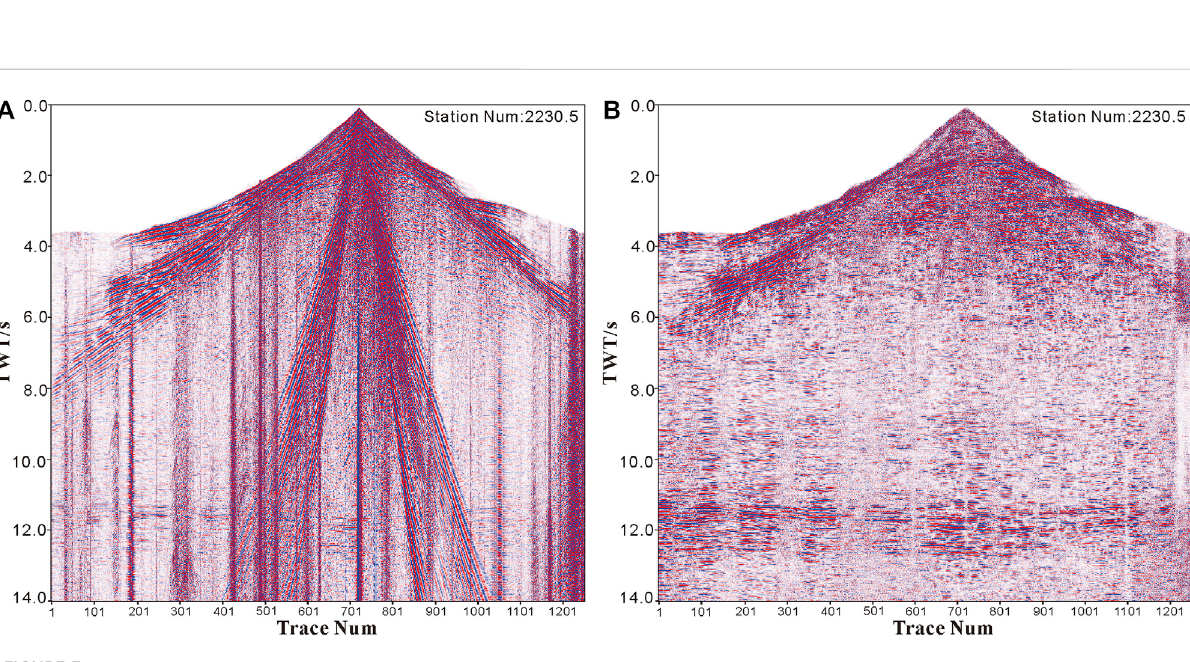
Frontiers in Earth